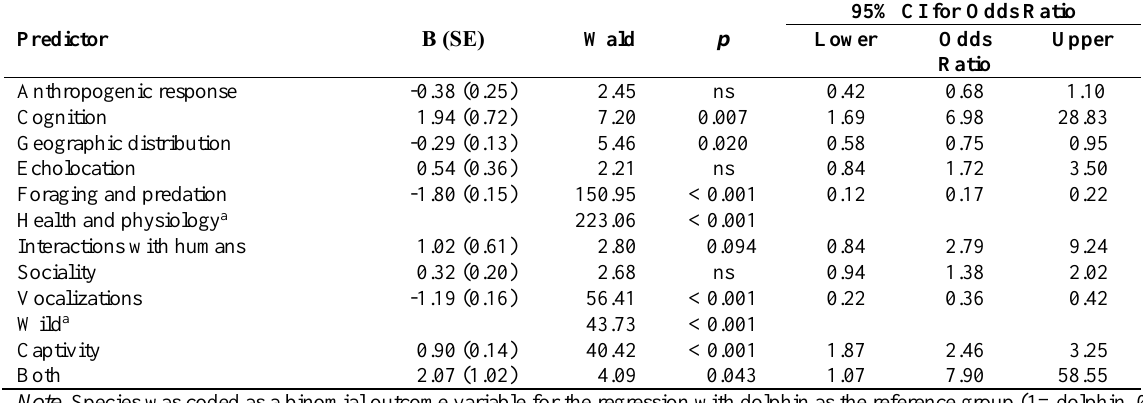
95% CI for Odds Ratio Upper Ratio